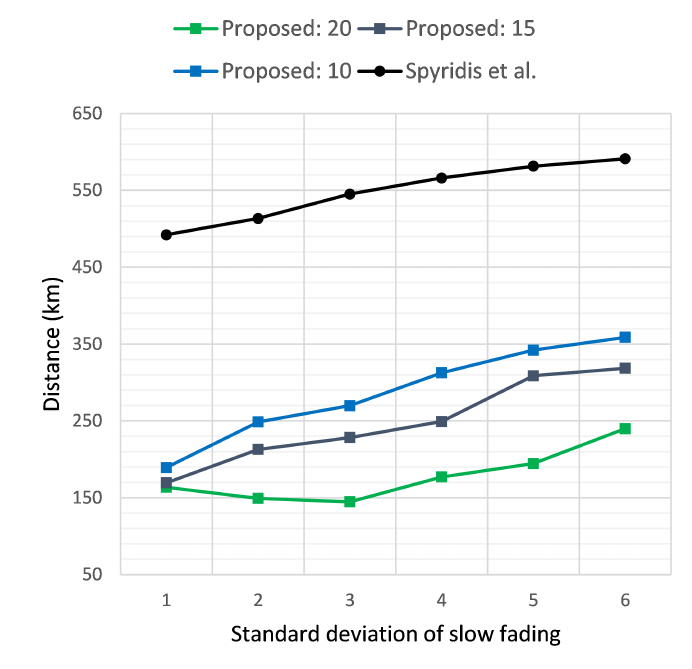
Figure 10. Total distance covered by all UAVs when the target sensor is placed at a distance of 3 km, versus the standard deviation σ of the additive noise. Comparison of the proposed method at clustering termination thresholds of 20, 15 and 10 dB and the previous